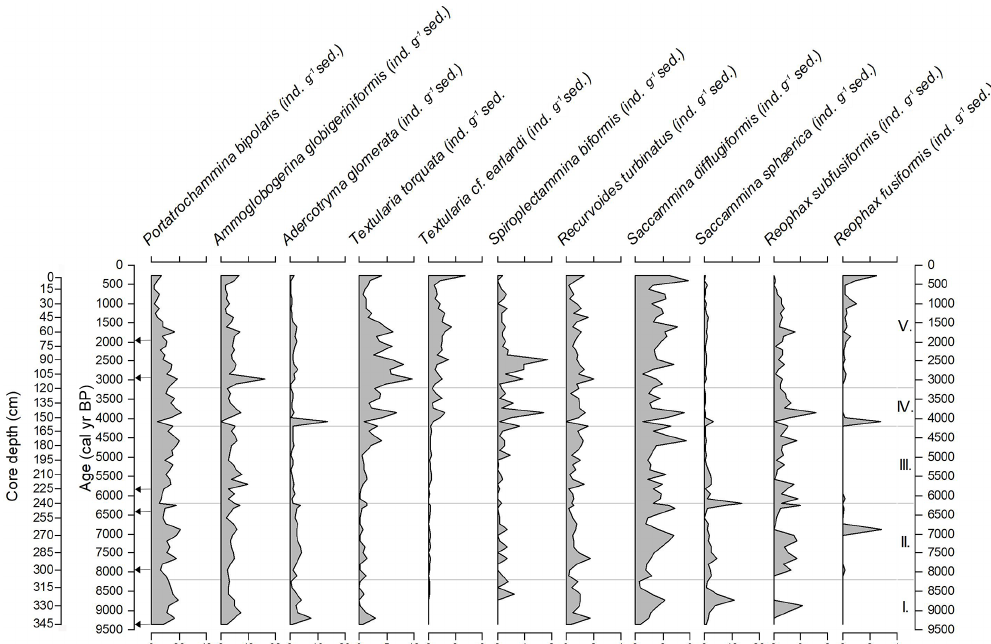
Figure A5. Foraminiferal concentrations of the most abundant ( > 5% in at least one sample) agglutinated benthic foraminifera species versus calibrated age along sediment core DA17-NG-ST07-73G. Ecozones (I–V) are shown on the right side of the figure. Black arrows next to the left primary y axis (age) mark radiocarbon dates. Note that the x axes have different scalings.